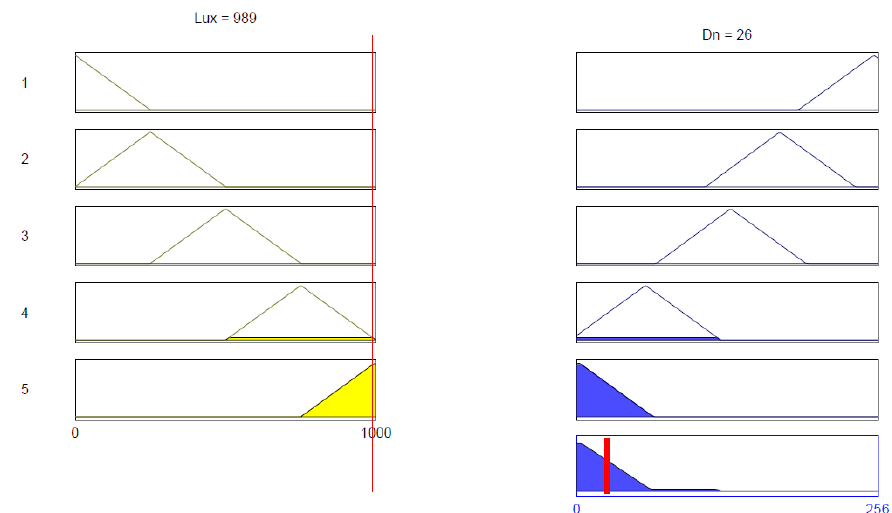
Figure 10. When Lux is 497 Lux, D n is 128.